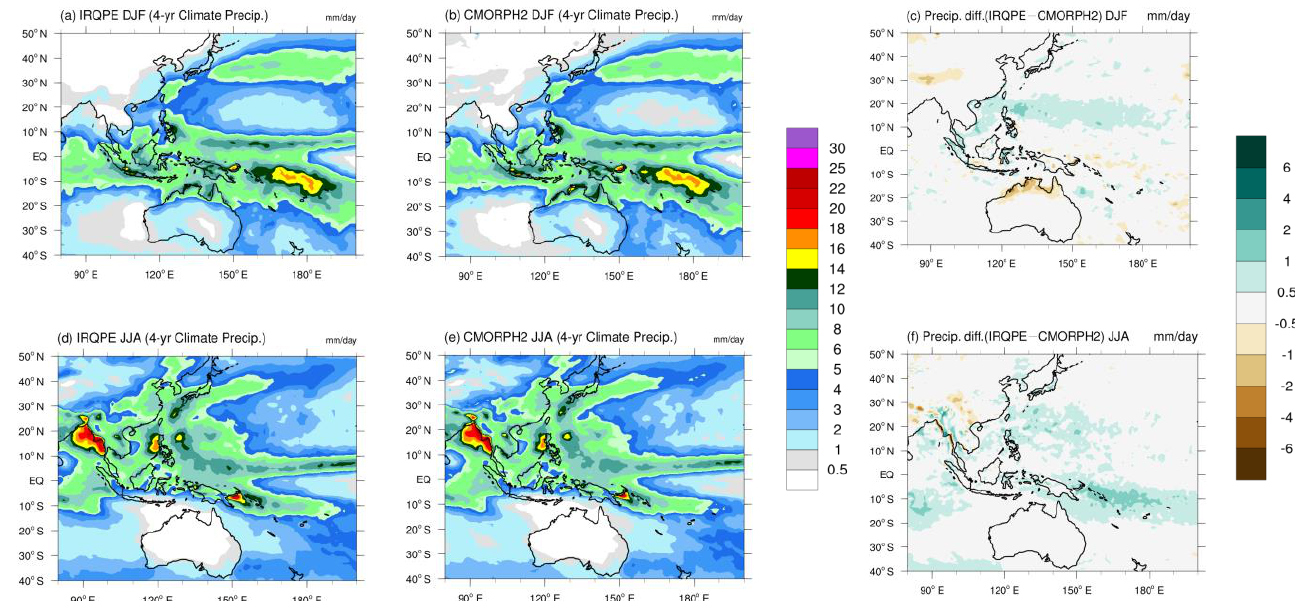
Figure 2. Four-year (top) DJF and (bottom) JJA seasonal mean: IRQPE ( a , d ), CMORPH2 ( b , e ), and the difference of the two datasets ( c , f ).